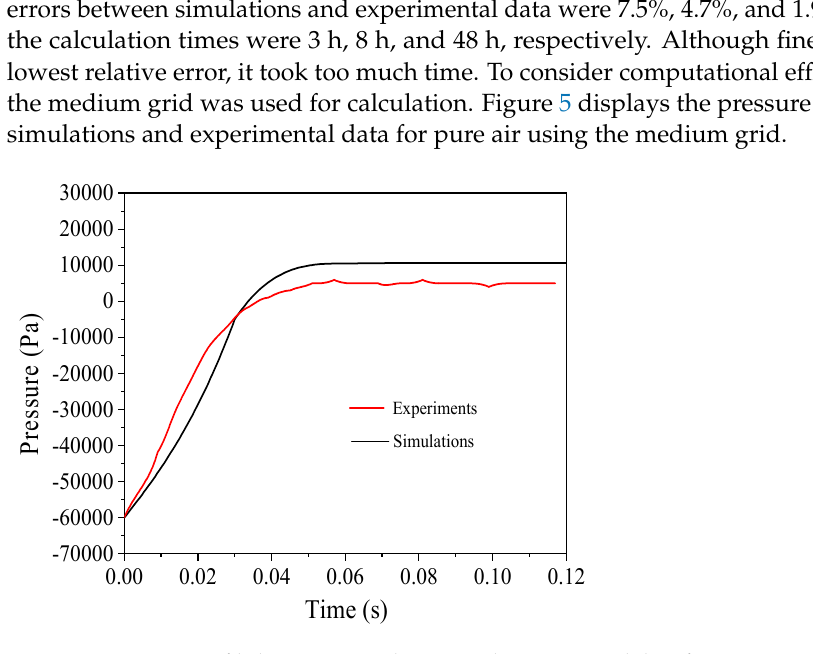
Figure 5. Pressure profile between simulations and experimental data for pure air using medium grid.